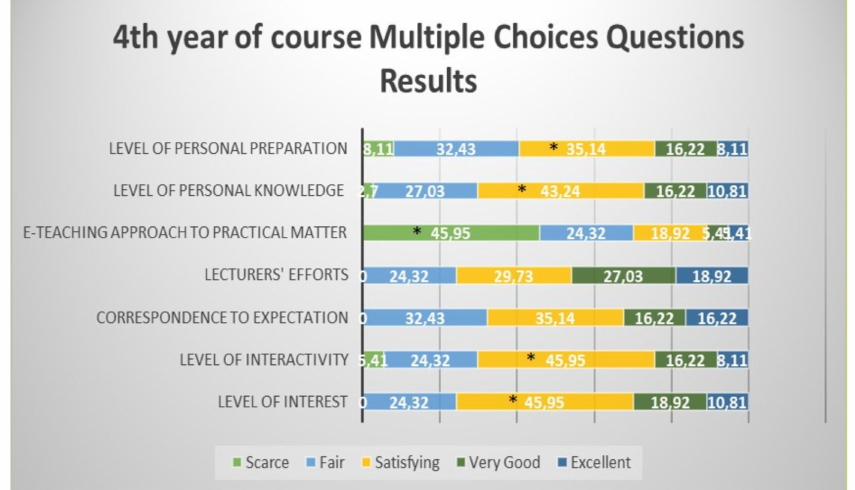
Figure 5. Questionnaire results for the fourth year student feedback to the e-learning and e-teaching approach. The numbers in the bars indicate the percentages of the answers received ( n = 301). * p < 0.05 (Pearson’s chi-squared tests). Although the correspondence to expectations and lecturers” efforts were mostly “satisfying”, the difference did not reach statistical significance.